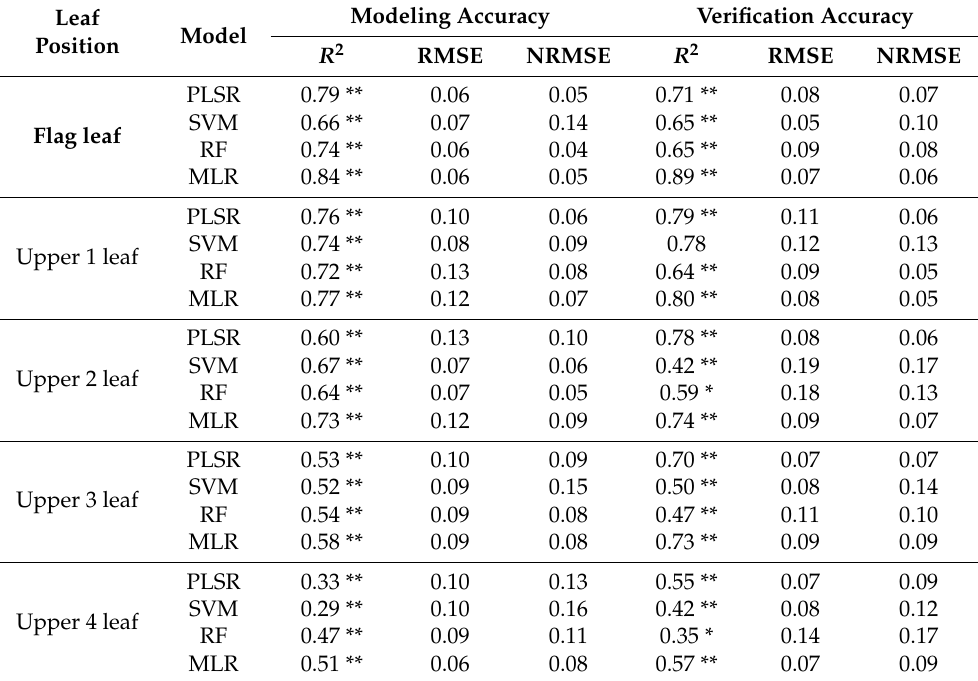
Table 7. Model accuracy of estimating nitrogen content based on sensitive wavelet.